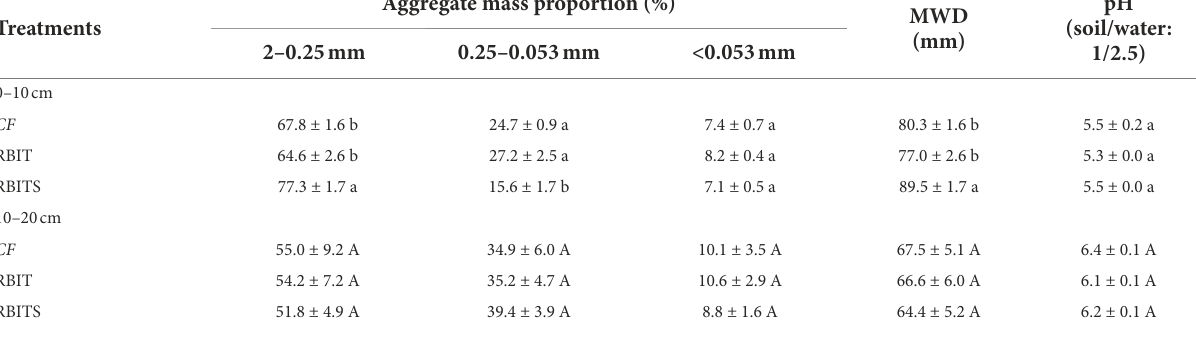
CF: conventional fertilization; RBIT: reduced basal and increased topdressing fertilizer rate; RBITS: RBIT combined with straw incorporation. MWD: mean weight diameter. Different lowercase and uppercase letters represent significant differences (P ≤ 0.05) among treatments in the 0–10 cm and 10–20 cm layers, respectively. Data: mean ± standard error